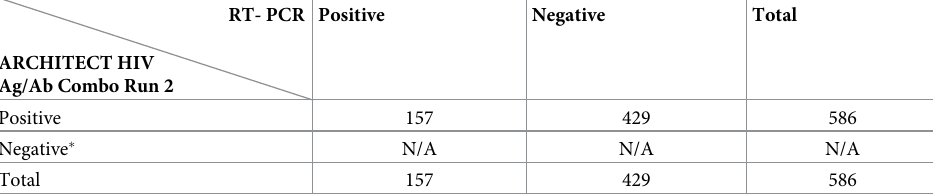
Table 3. Comparison between ARCHITECT 1 HIV Ag/Ab combo Run 2 and RT-PCR.